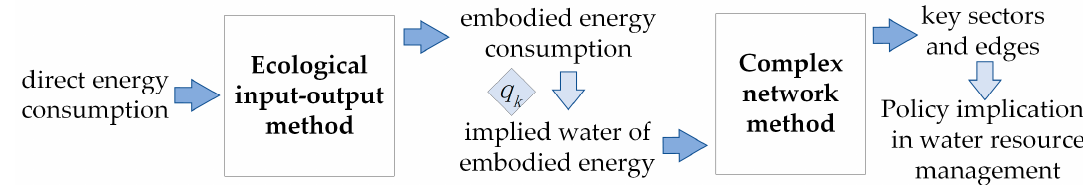
Figure 3. Flow diagram of the ecological input–output method and the complex network. Direct energy consumption is the input data for the ecological input–output method, and embodied energy consumption is obtained by calculation. Further, the implied water of embodied energy is calculated by multiplying the embodied energy consumption by q k , and then is input into the calculation of complex network indicators. Finally, key sectors and edges are identified by complex network characteristics to better implement water resource management.